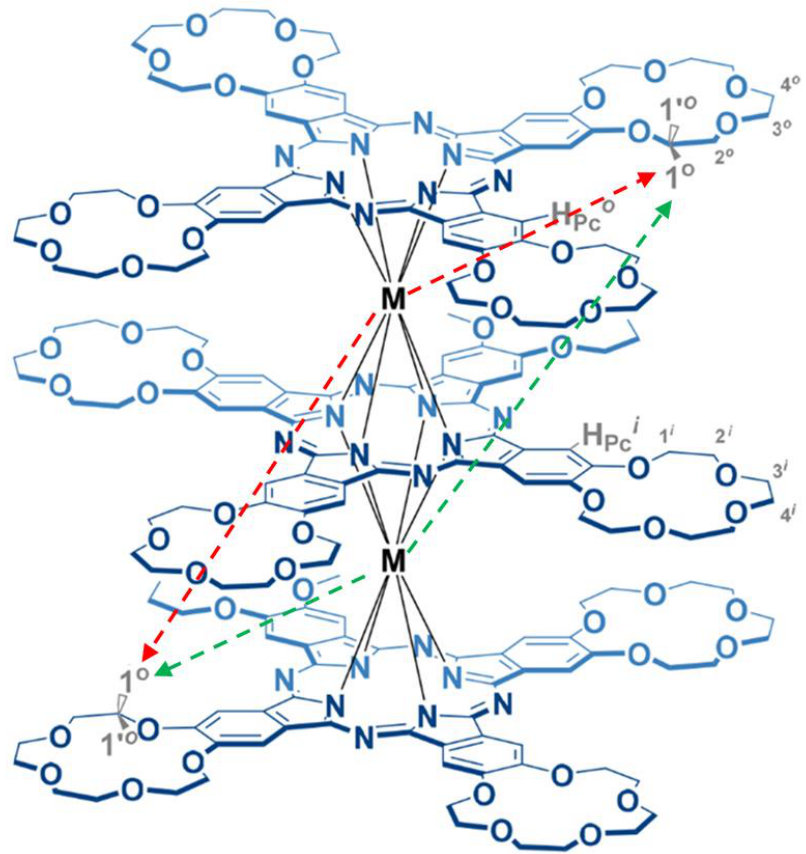
Figure 1. Schematic representation of the structure of the complexes 1 and 2 with an example of the arrangement of “ paired ” protons (where M = Tb ( 1 ) or Dy ( 2 )).